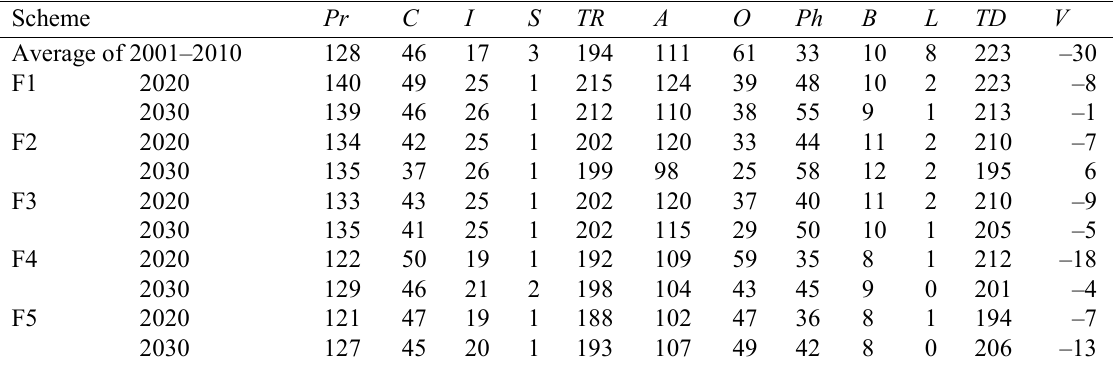
Table 2 The dynamic balance analysis of shallow groundwater in different level years and schemes (10 8 m 3 ). Scheme